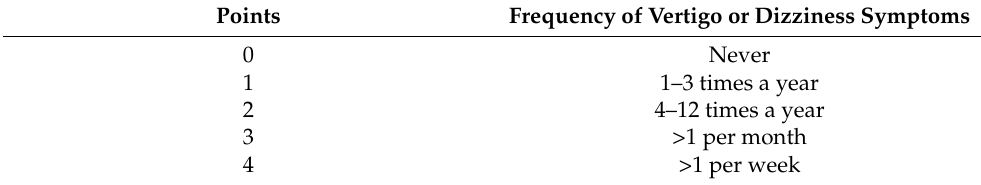
Table 3. Vertigo symptom scale Likert Scale